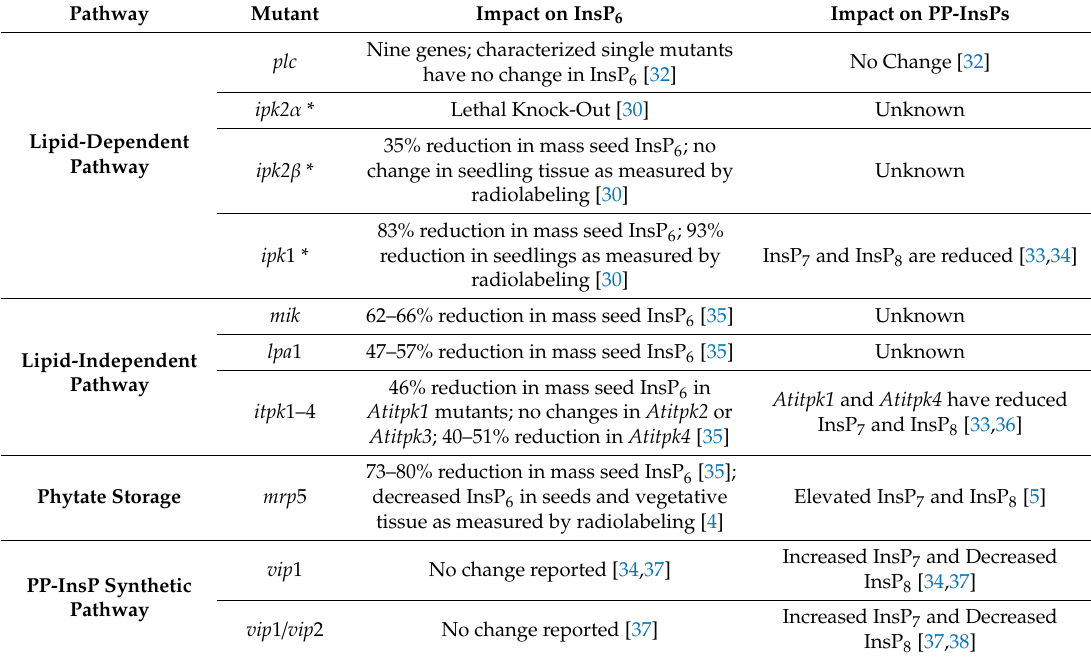
Table 1. Loss-of-function Arabidopsis mutants and impacts on InsP 6 and PP-InsP levels. Arabidopsis is a simple model system that can be used to gauge the impacts of genetic changes on InsPs. The table shows the impact on InsP 6 and PP-InsPs in Arabidopsis mutants for enzymes involved in InsP synthesis. Mutants for enzymes important in both the Lipid-Dependent and Lipid-Independent pathways are indicated